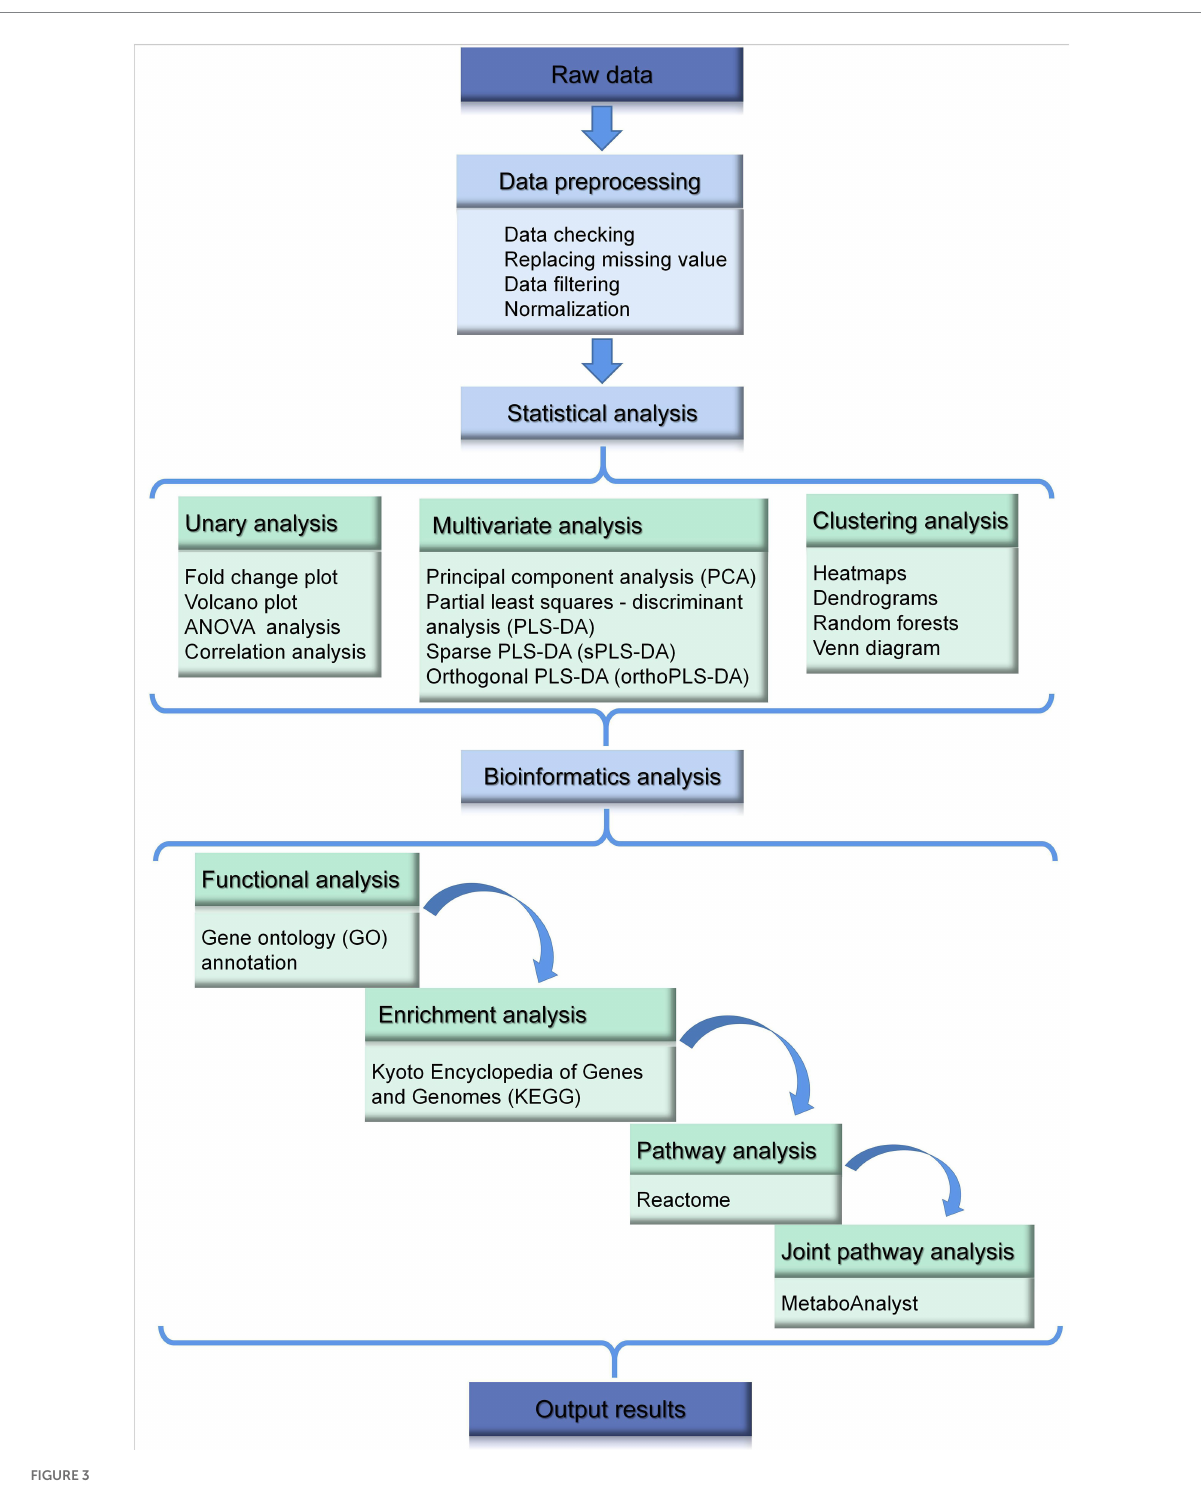
FIGURE 3 General data processing and bioinformatics analysis in